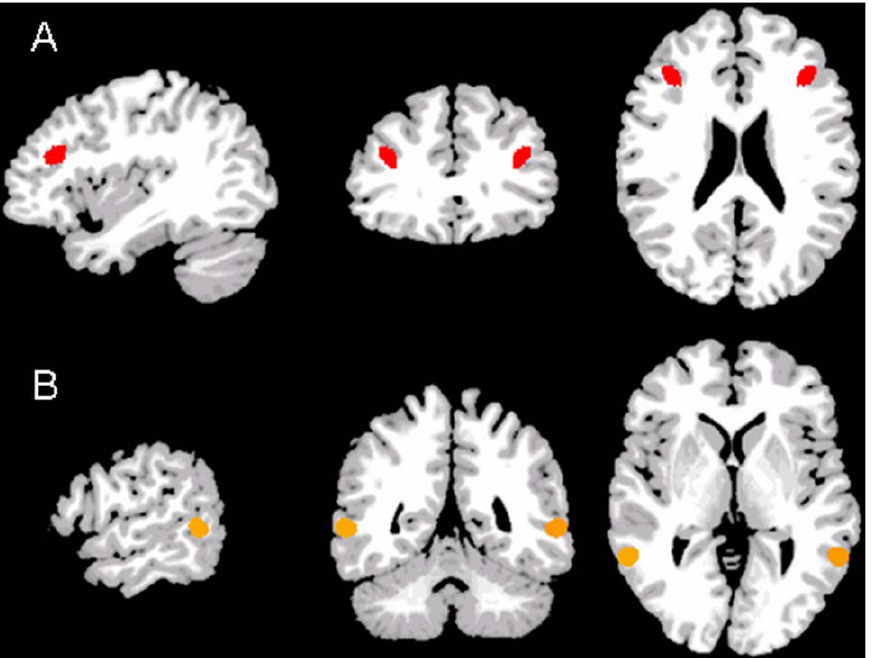
Figure 2. The MFG (A) and MTG (B) ROIs. The figure presents the selected ROIs in three orthogonal views (sagittal, coronal, axial). ROIs were extracted from a contrast map between CTR targets vs. CTR primes. The x,y,z Talairach coordinates for the right MFG and MTG are set on the center of mass coordinates of each ROI as follows: x=36, y=30, z=21; x=59, y= 2 50, z=5, respectively. The left ROIs were achieved by flipping the right ones. The functional ROIs were superimposed on a reference anatomical image (Holmes et al., 1998). Display follows radiological convention.